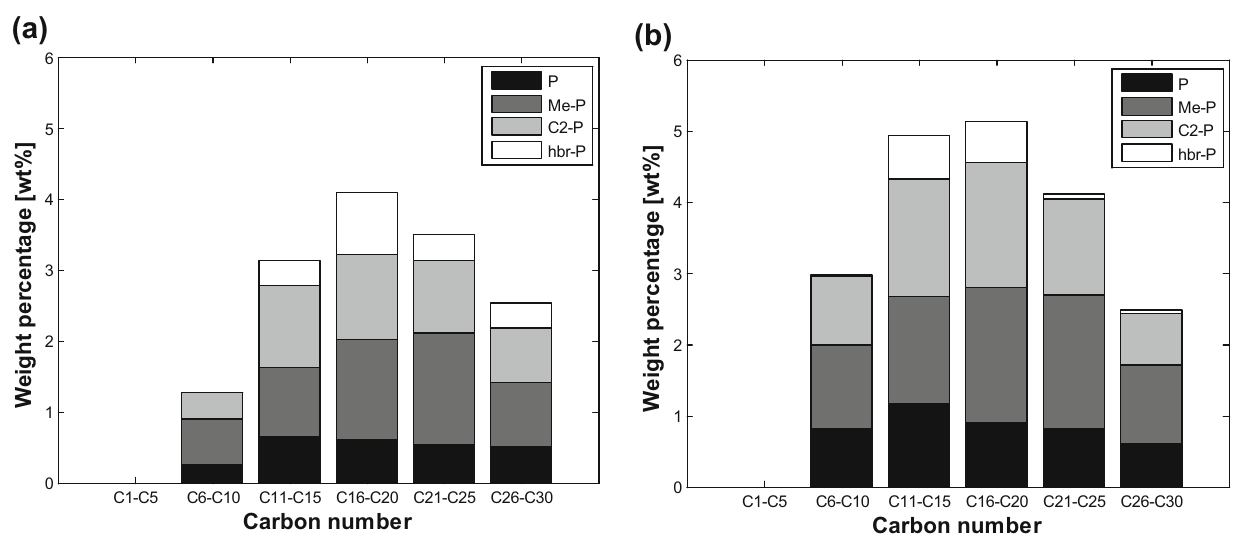
Fig. 5 Branching distribution of paraffins in a original and b processed Marmul